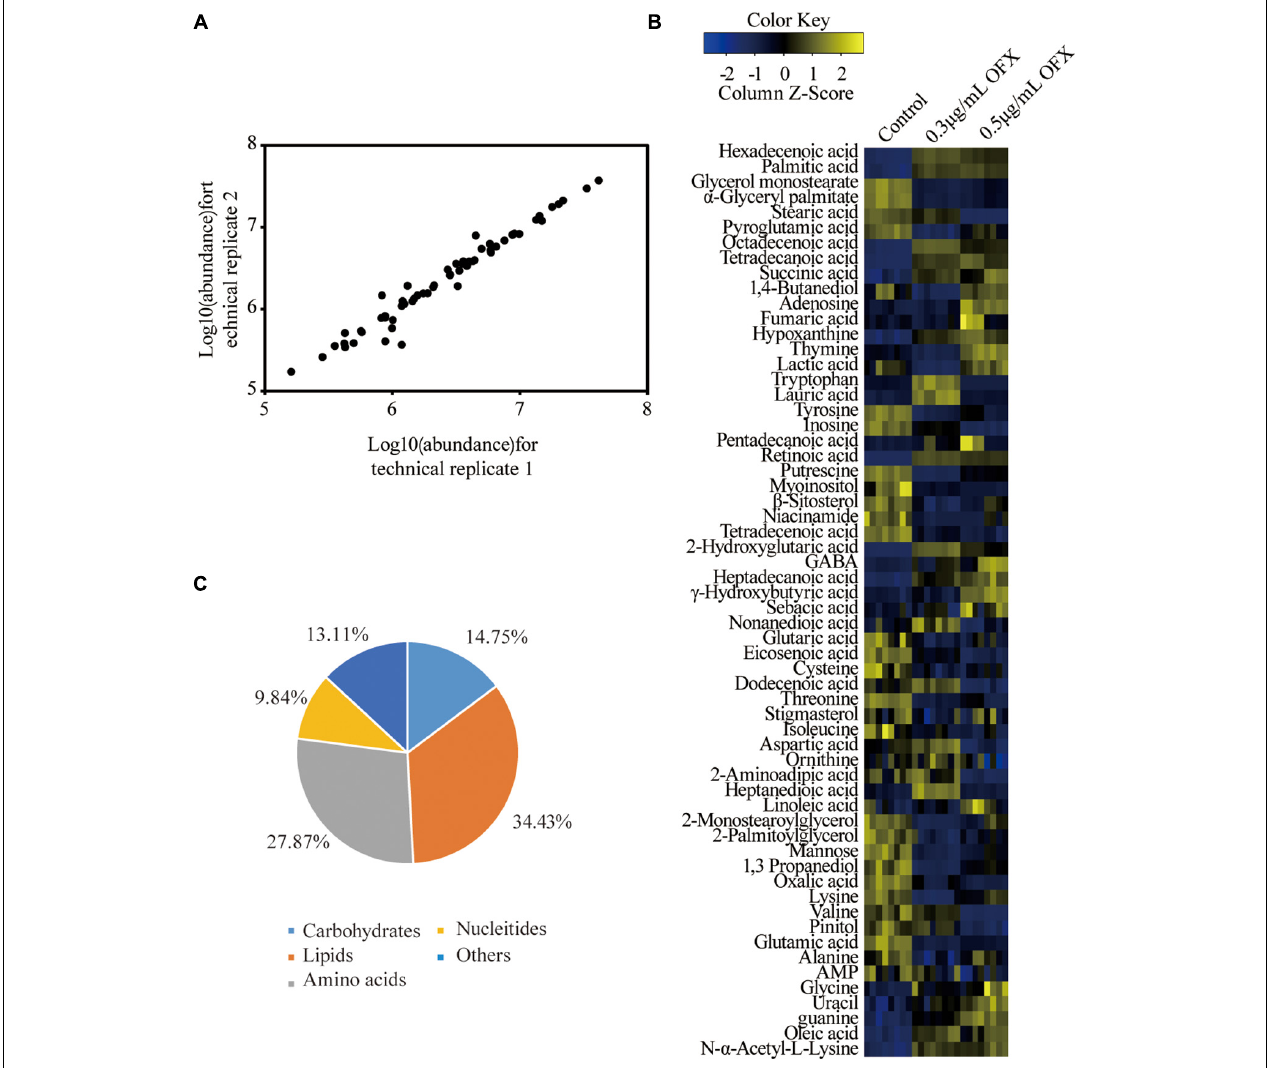
FIGURE 2 | Metabolomic profiles of V. alginolyticus in response to OFX. (A) Heat map of identified metabolites. Scale is shown at bottom, where blue to yellow represents low-to-high abundance. (B) Reproducibility of metabolomic profiling. (C) Functional categories of the identified